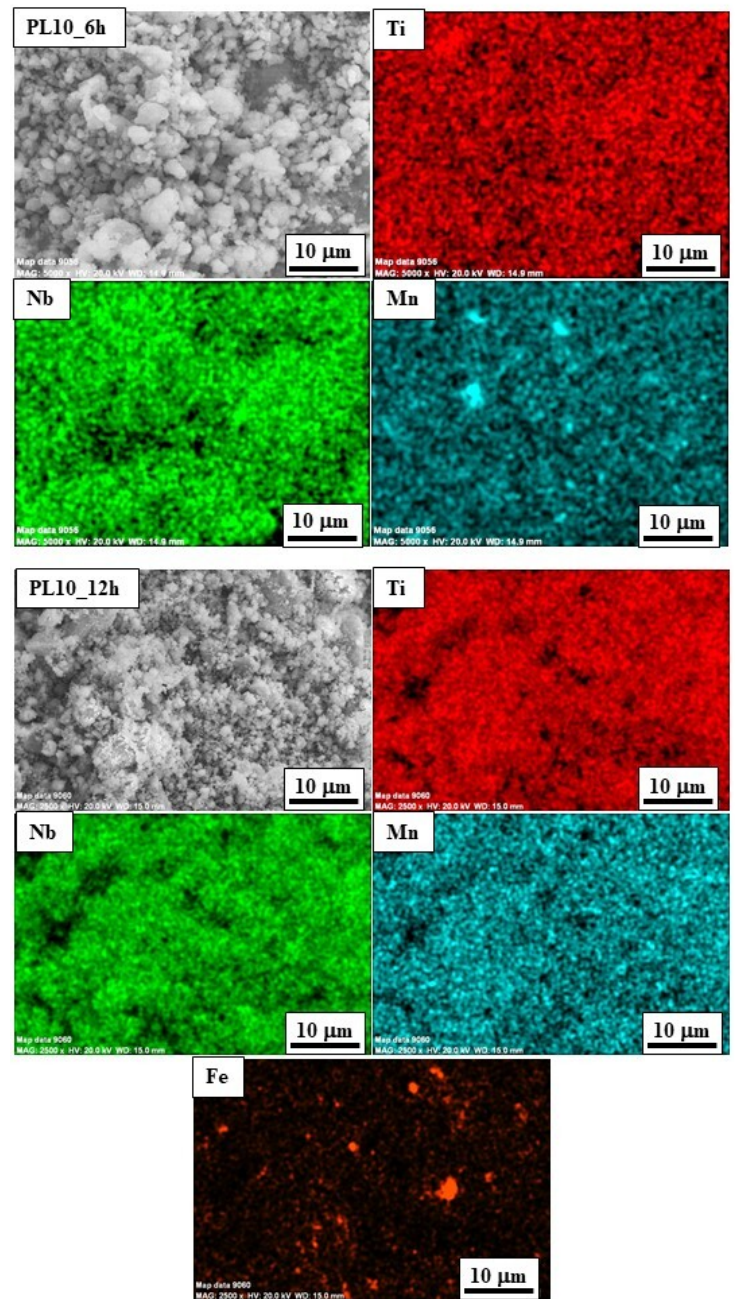
Figure 7. Characteristic compositional XEDS-SEM mapping for the elements existing in the PL10 specimens milled at 6 h and 12 h. Ti: red; Nb: green; Mn: light blue; Fe: orange. After 6 h of milling time, the Ti and Nb elements in the SP10_6h seemed to be highly alloyed, due to the uniform contrast that was observed across all the particles in the corresponding Ti (red color) and Nb (green color) XEDS-SEM micrographs, although the Mn (light-blue color) was unevenly distributed across the particles. These results are in good agreement with the deconvoluted XRD patterns that are shown in Figure 3a, where a low intense Ti (100) peak and a well-defined Mn peak were detected, corroborating the not total conversion of Ti, and mainly Mn, into the TiNbMn alloy. The difference between the degrees of alloying could be associated with the higher solubility of Ti and Nb than Mn, as can be corroborated by the corresponding Ti–Nb and Mn–Nb phase diagrams